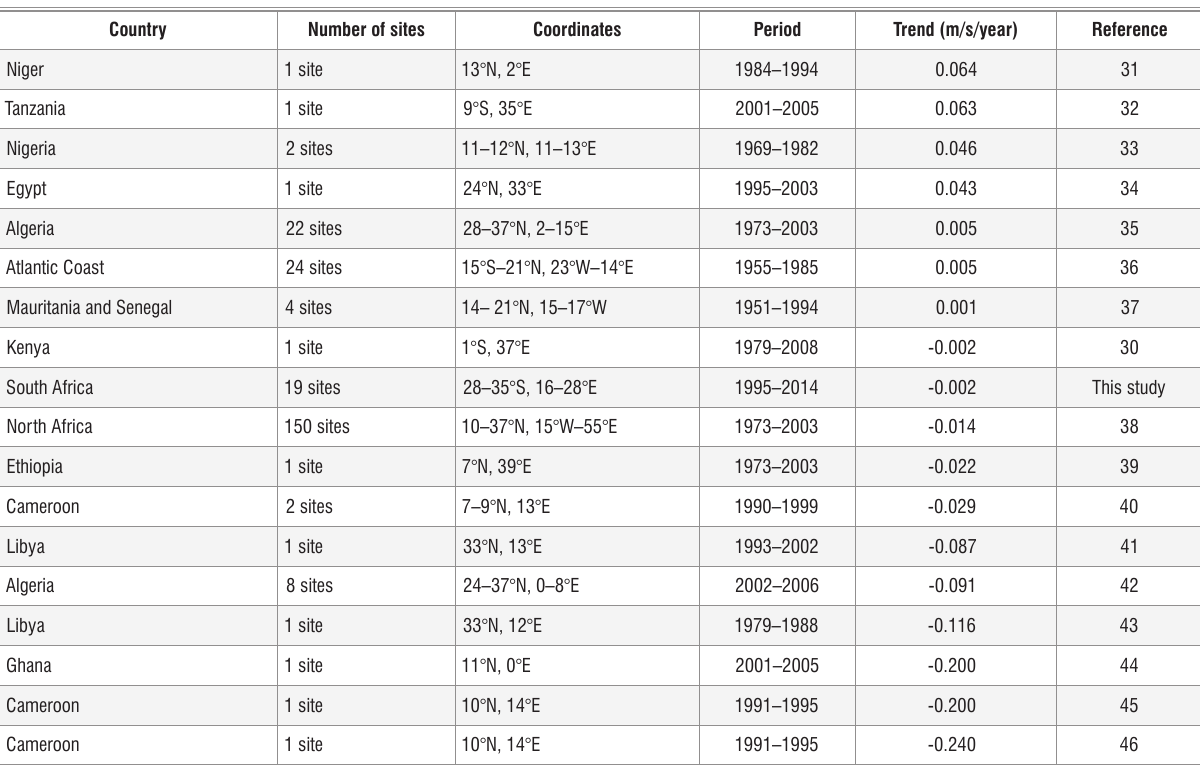
Recent wind speed trends for various African